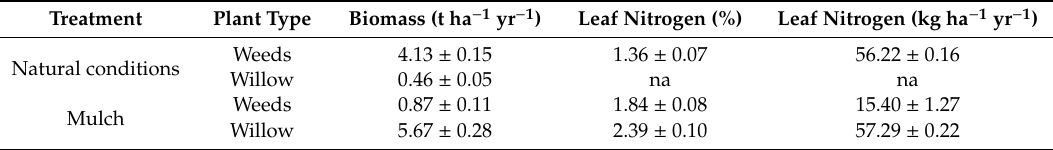
Table 1. Annual average biomass production and leaf nitrogen content of both weeds and willow in land under natural conditions (no weed control) or plastic mulch. Values shown are mean ± SE.